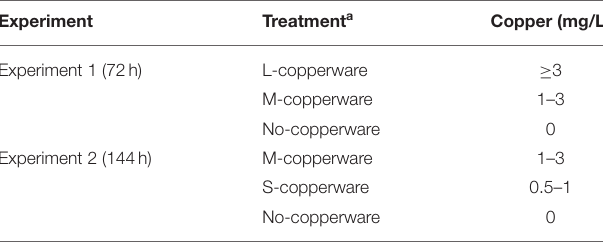
TABLE 2 | Copper concentration after water treatment with different sizes of COPPERWARE ® filters at the end of experiments 1 and 2. Experiment